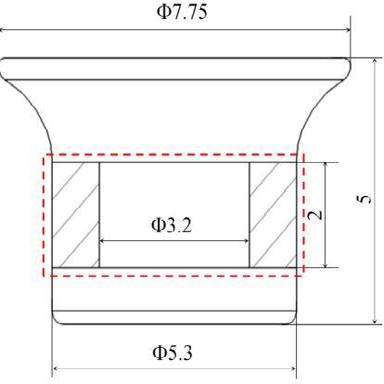
Geometrical sizes of the rivet.